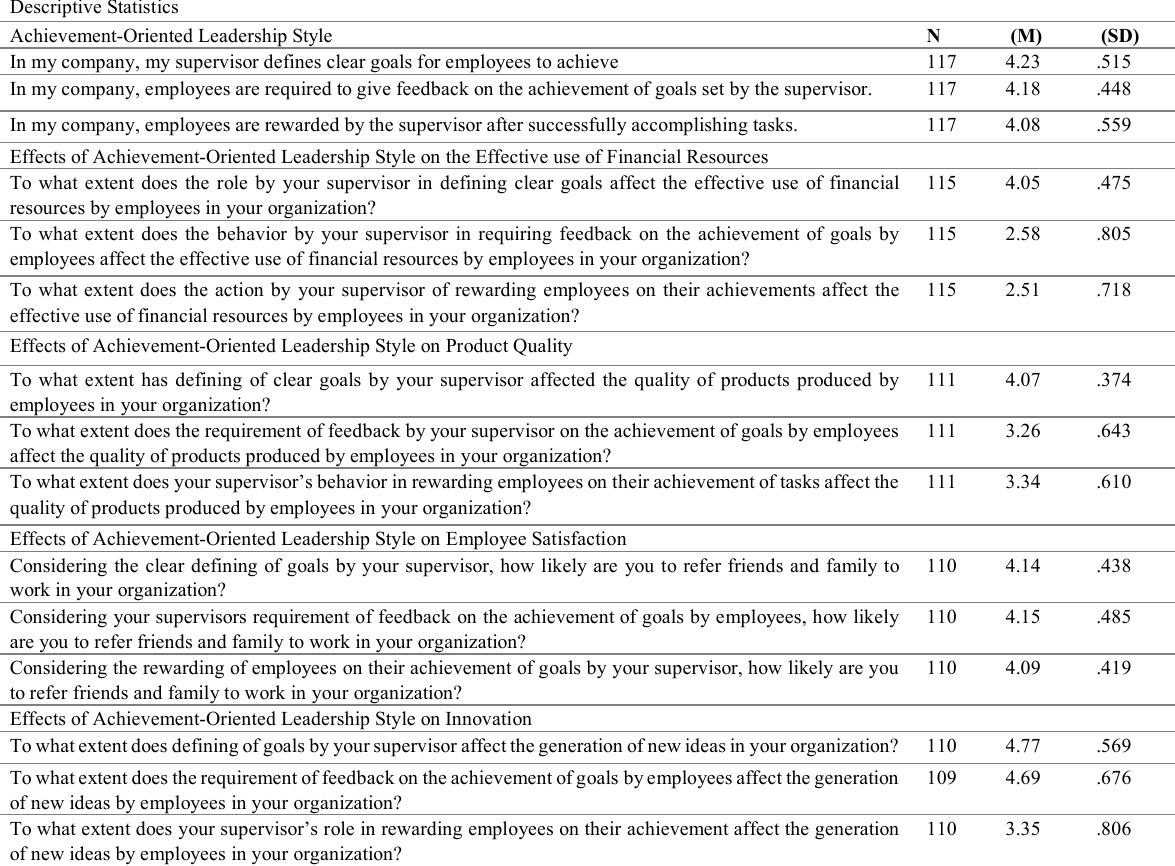
Table 7: Mean and standard deviation for achievement-oriented leadership